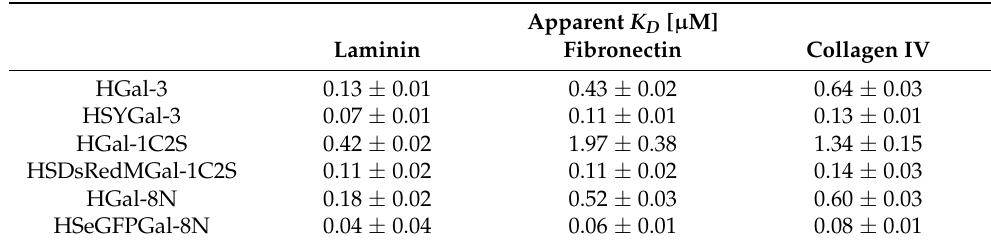
Figure 6. Binding of HGal-3 and HSYGal-3 on ECM glycoproteins. The binding of HGal-3 ( A ) and HSYGal-3 ( B ) on laminin ( ⬛ ), fibronectin ( (cid:4496)(cid:4497) ), and collagen IV ( ▲ ) is shown in a solid-phase assay. Galectin binding was detected by an anti-His 6 -antibody, and conversion of TMB was measured using three data points. Error bars indicate standard deviations. Table 4. Apparent K D values of HGal-3 and HSYGal-3 binding to ECM glycoproteins in a solid-phase binding assay. Values were calculated by non-linear regression assuming one-site